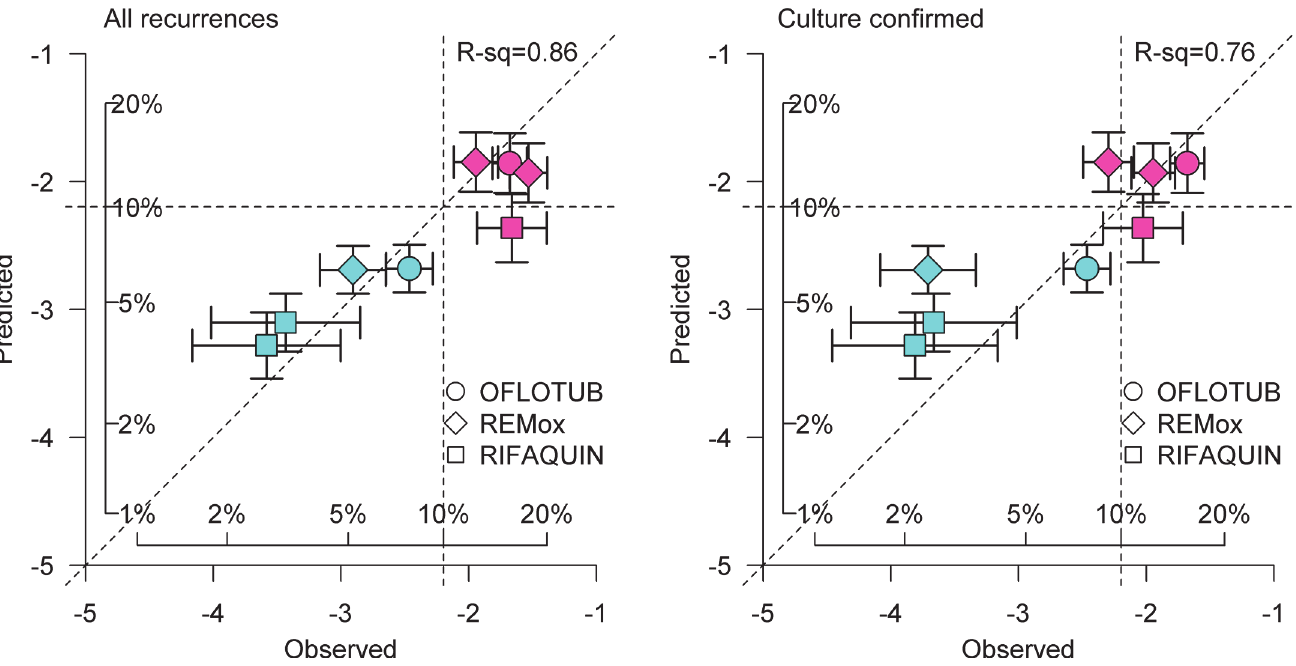
Fig 1. Observed and predicted proportions of subjects with tuberculosis recurrence in the 8 arms of the 3 trials comprising the validation dataset, based on all recurrences (left panel) and only those with full culture confirmation (right panel). Recurrences were predicted using the original mathematical model as reported in reference [5]. Axes indicate logit-transformed recurrence risk; inset scales indicate corresponding percentages. Red symbols indicate 4 month regimens; green symbols indicate 6 month regimens. Error bars indicate 80% confidence intervals (10%-90%). Vertical and horizontal dotted lines indicate recurrence rates of 10% (-2.2 after logit